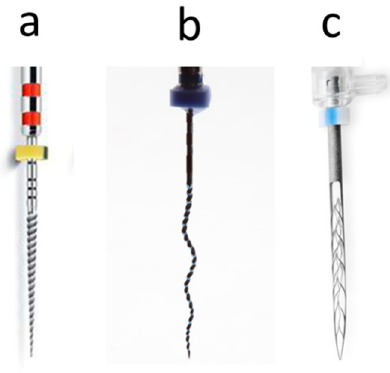
Figure 2. Adaptive nickel-titanium mechanized instruments. ( a ) Traditional rotary file, which cannot adapt itself to an oval root canal. ( b ) XP-endo shaper with a snake like shape and motion. ( c ) Self-adjusting file (SAF) which can adapt its shape to an oval root canal. The self-adjusting file (SAF) system (ReDent Nova, Ra’anana, Israel) was specifically designed to address the challenge of oval-shaped root canals. The SAF is a hollow, compressible file made